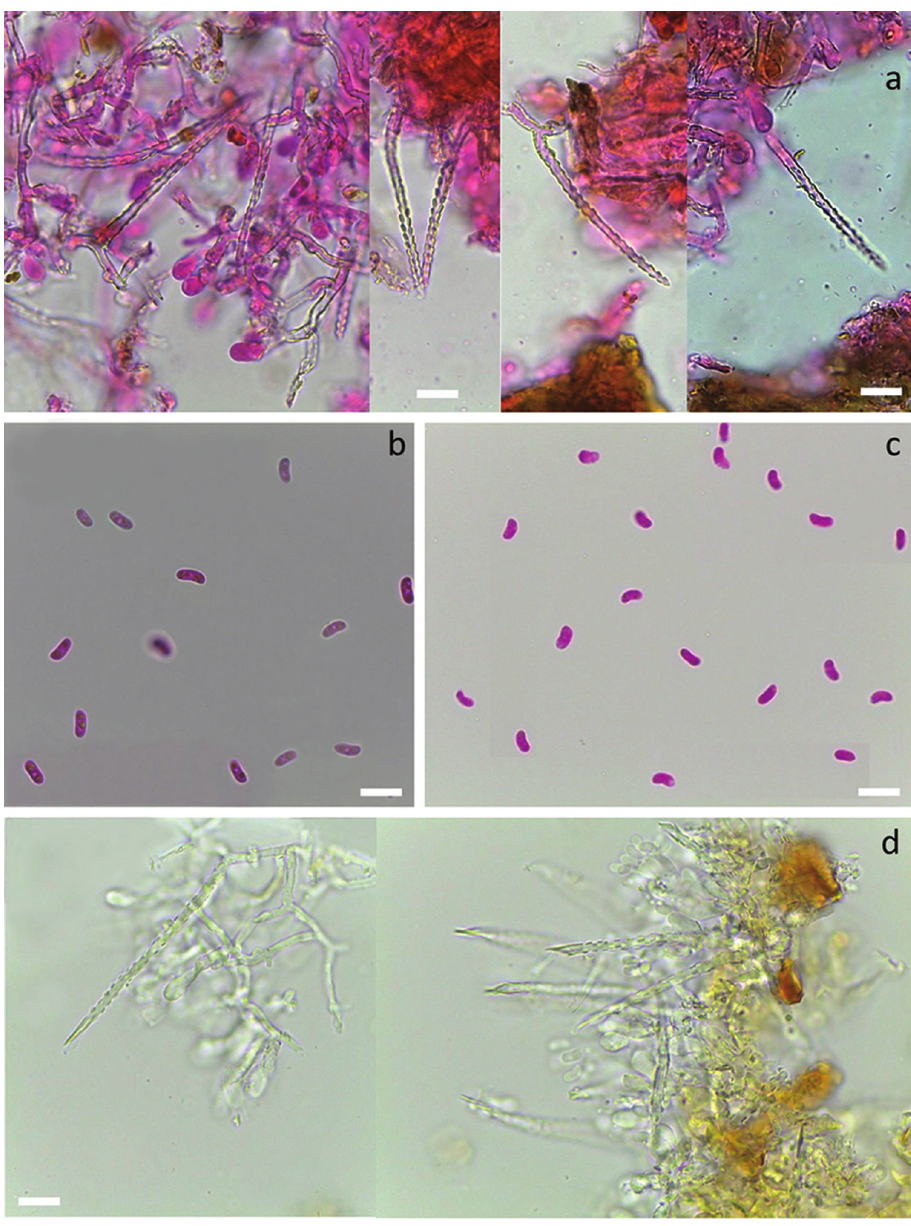
Figure 7. Species of Subulicystidium with smallest cylindric basidiospores. Subulicystidium harpagum (KAS:L 1726a, holotype): a cystidia b basidiospores. Subulicystidium parvisporum (KAS:L 0140, holo- type): c basidiospores d cross sections through fruit-body. Preparations a, b, c done in 3% aqueous solu- tion of potassium hydroxide (KOH) mixed with 1% aqueous solution of Phloxine, preparation d simply in KOH. All scale bars equal 10